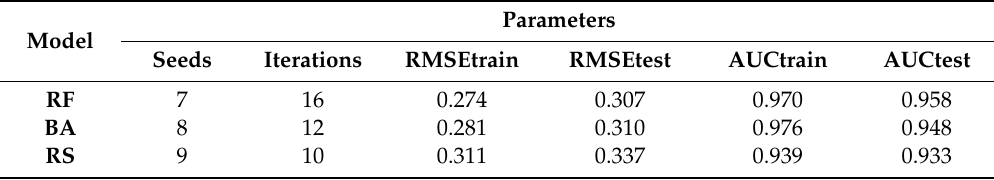
Table 2. Optimal parameters of shallow landslide models for the study